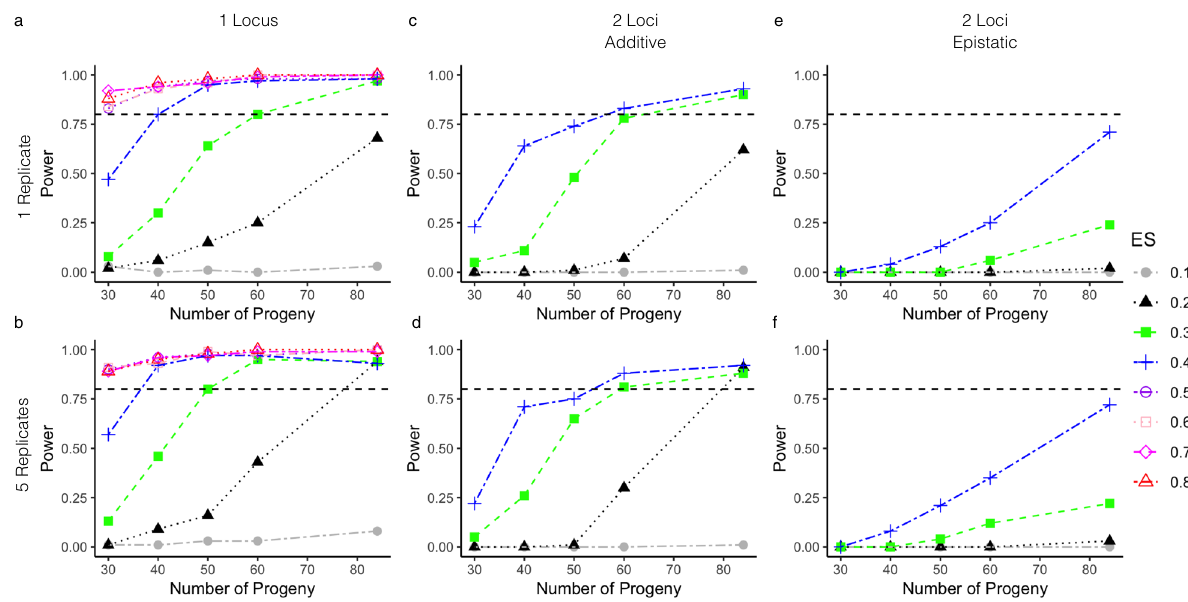
Fig. 5 Power analysis for different size progeny sets. Power curves are shown from simulated phenotypes for the NF54 × NHP4026 progeny for different size progeny sets. The top row a , c , e shows power curves where the phenotype only has a single replicate per progeny strain and the bottom row b , d , f shows results for fi ve replicate phenotype values per progeny strain. The fi rst column a , b shows results for a single locus effect, the second column c , d shows results for an additive two loci effect and the third column e , f shows results for an epistatic interaction between two loci. The horizontal black dotted line denotes 80%